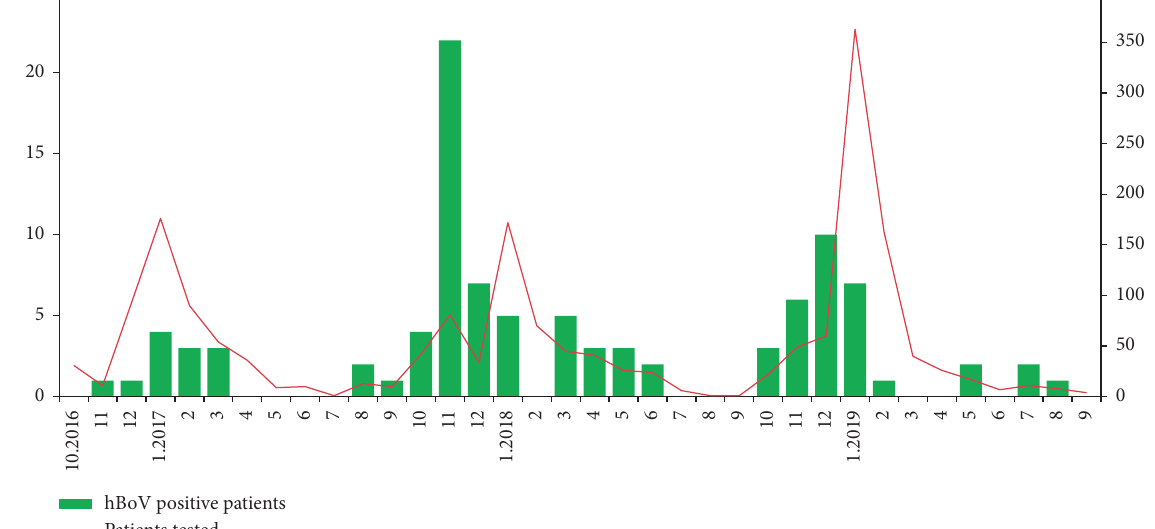
Figure 3: Monthly distribution of hBoV detections in Bulgaria,